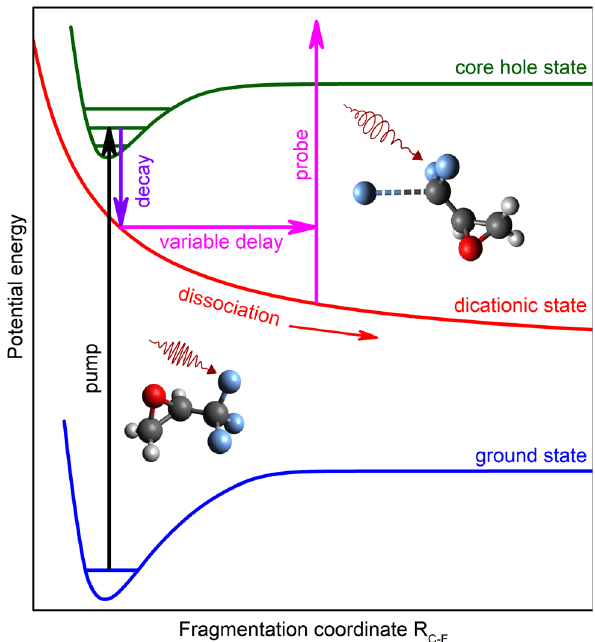
Fig. 1 Principal scheme of the process. The X-ray pump pulse ejects a 1s photoelectron from one of the fl uorine atoms of the neutral C 3 H 3 F 3 O molecule. This step is represented by the upward transition from the ground state to the core-ionized state of the molecule. In the second step, the core-ionized state undergoes Auger decay which populates dicationic states of the molecule as indicated by the downward transition pointing to the repulsive curve. The doubly charged molecule can Coulomb-explode into the fl uorine ion and the singly charged mother- fragment. During this dissociation, a delayed circularly polarized X-ray pulse probes the asymmetric scattering of the 1s photoelectron emitted from one of the remaining fl uorine atoms attached to the singly charged mother-fragment. This second electron emission in an altered Coulomb potential of the transient system is shown by the upward transition at an enlarged distance between the ionic fragments. The present experiment analyzes the PECD of this secondary F 1s photoelectron of C 3 H 3 F 2 O + as a function of the time delay between the